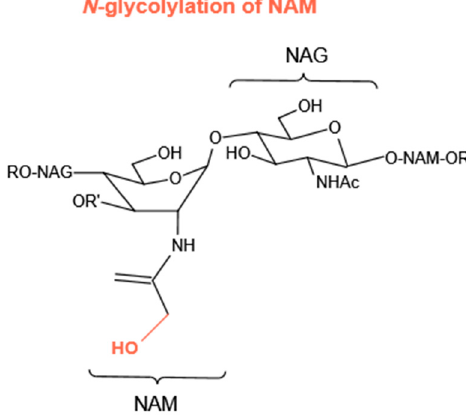
Figure 6. N -glycolylation of